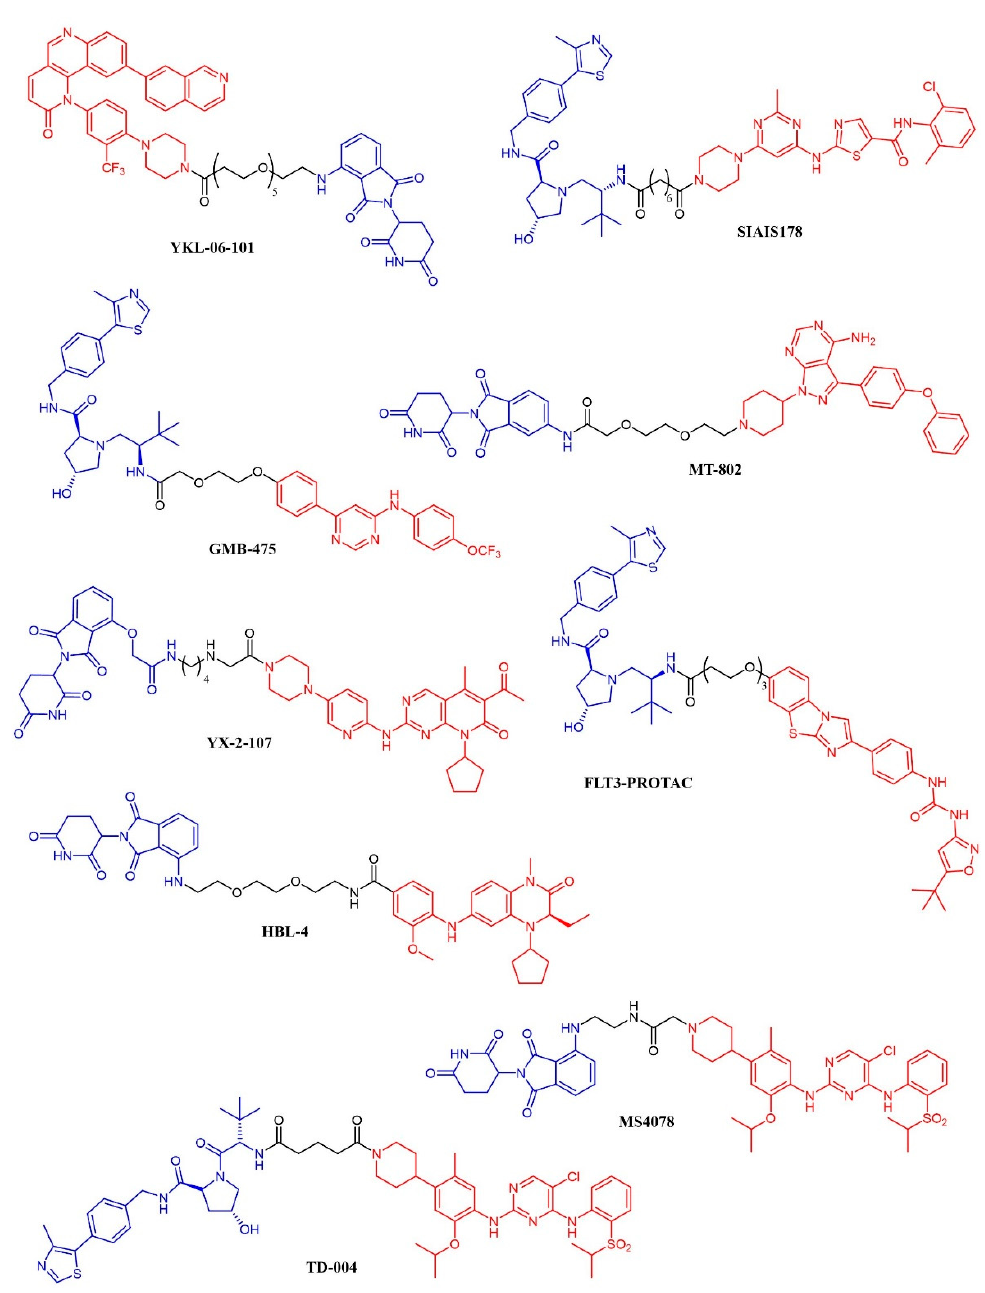
Figure 10. Chemical structure of kinase inhibitor derived PROTACS. Ubiquitine ligase recognizing moiety is depicted in blue; kinase recognizing moiety is depicted in red; linker is depicted in black.